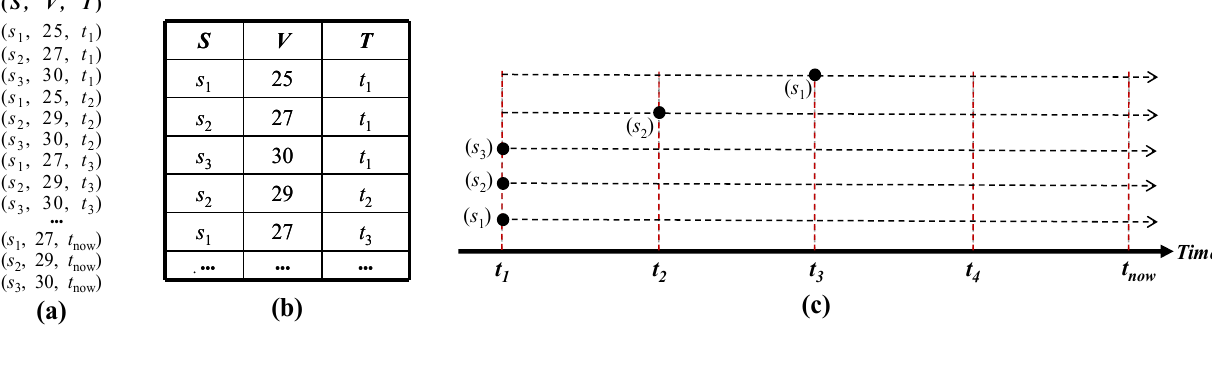
Figure 3. Processing of TPI method ( a ) incoming data stream; ( b ) storage of table in memory; ( c ) time-points representing the measured